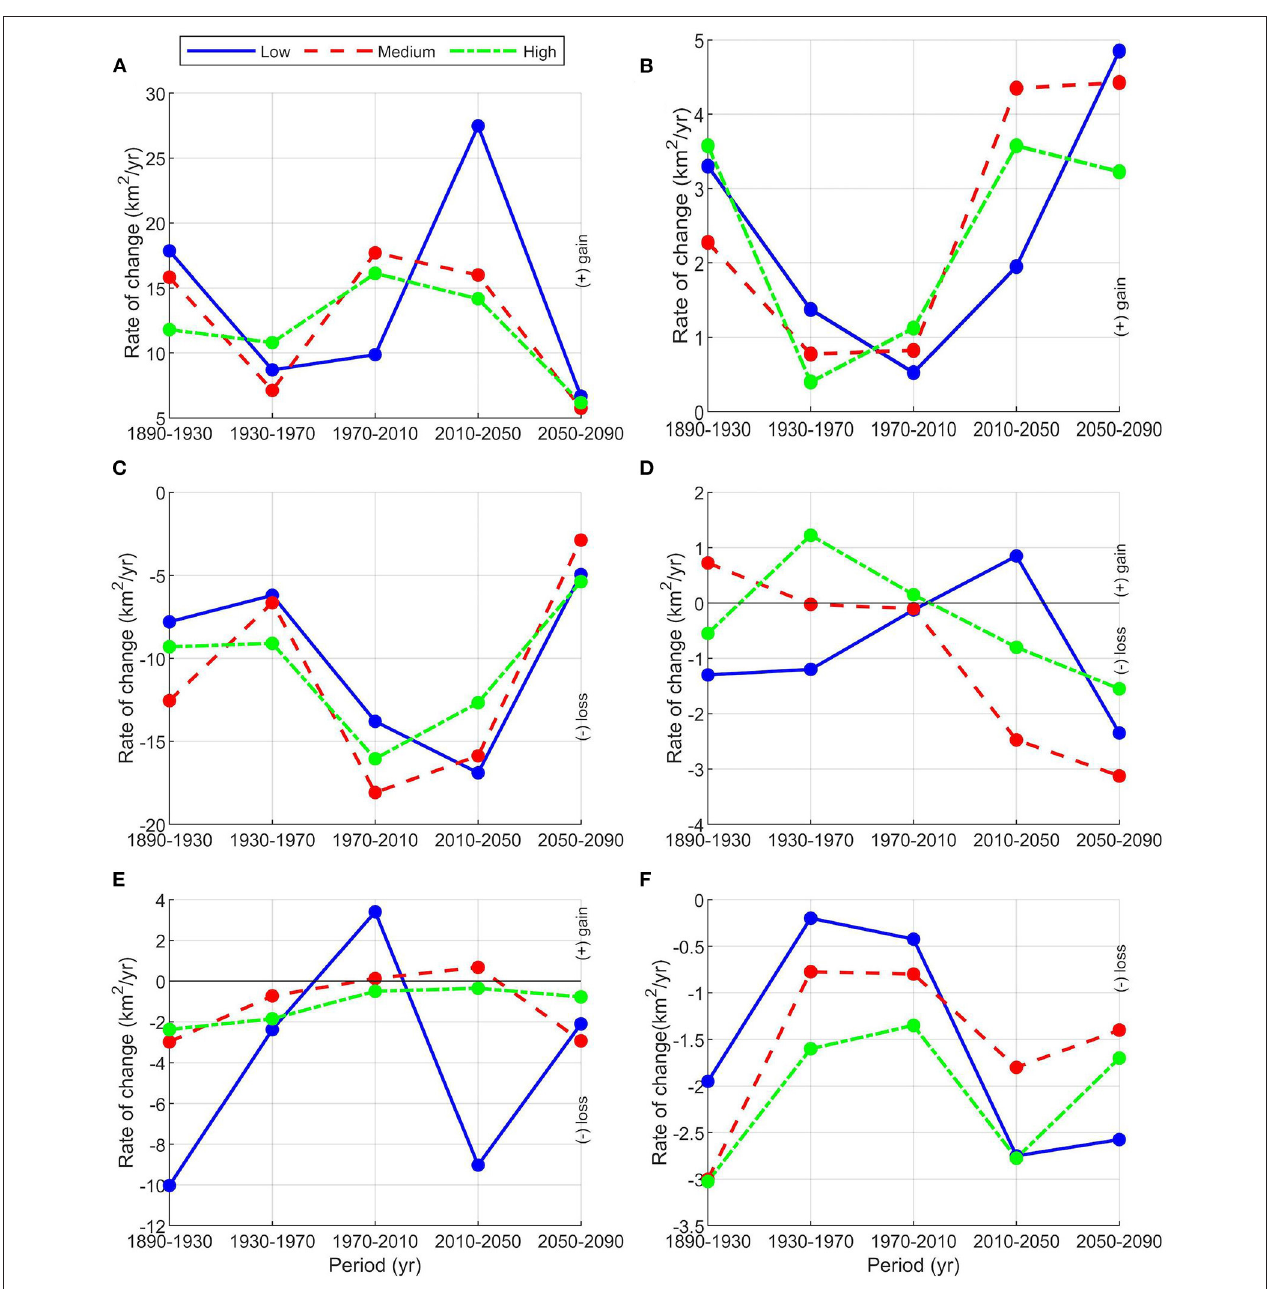
FIGURE 10 | Rate of change in coverage area between successive eras of the (A,B) coastal, (C,D) transition, and (E,F) hydrologic flood zone at the (A,C,E) Barataria and (B,D,F) Lake Maurepas watershed for different flood magnitudes. The blue, red, and green lines represent low, medium, and high flood events, respectively. Positive values represent that the coverage area of a flood hazard zone for a given era has increased compared to the previous era within the period. Negative values represent that the coverage area of a flood hazard zone for a given era has decreased compared to the previous era within the period.